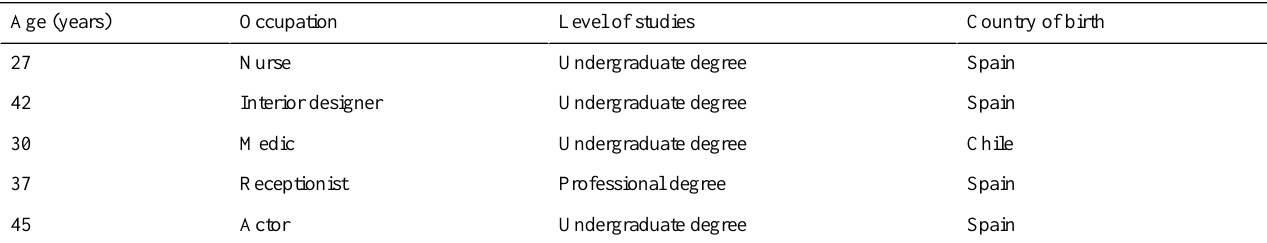
Table 1. Sociodemographic characteristics of